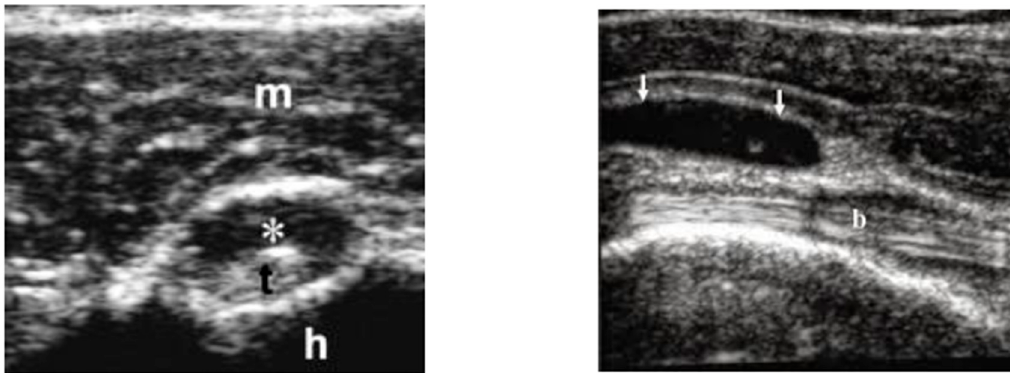
Figure 1. Long-head-biceps exudative tenosynovitis (left, *) and subdeltoid bursitis (right, arrows). m is for muscle; t is for long-head biceps tendon; h is for head (omeral head); b is for bursa.